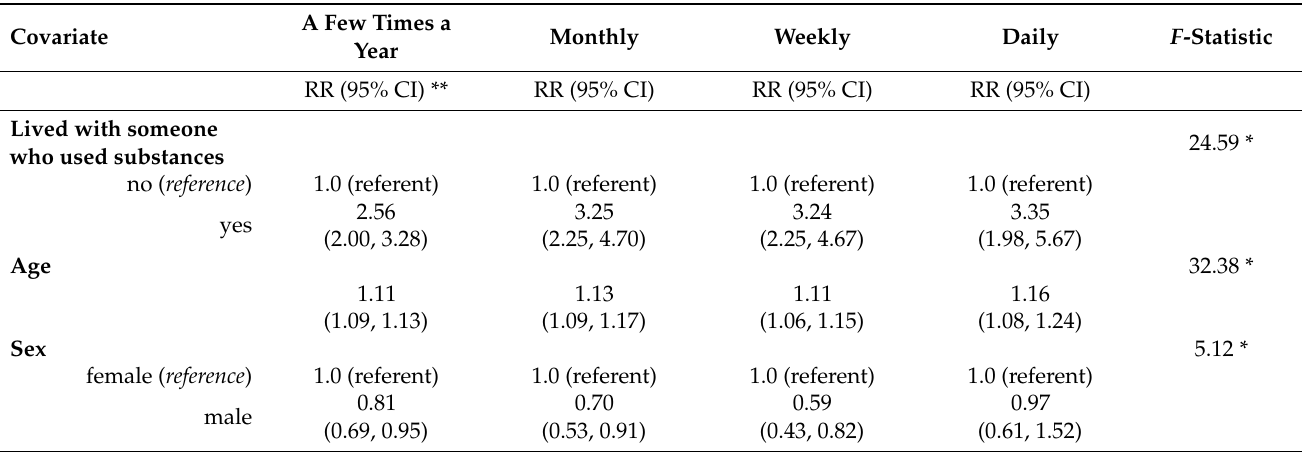
Table 5. Multinomial regression models for the association between having ever resided with some- one who used substances and the frequency of children’s depression (referent = never experienced depression)—2019 National Health Interview Survey (n =